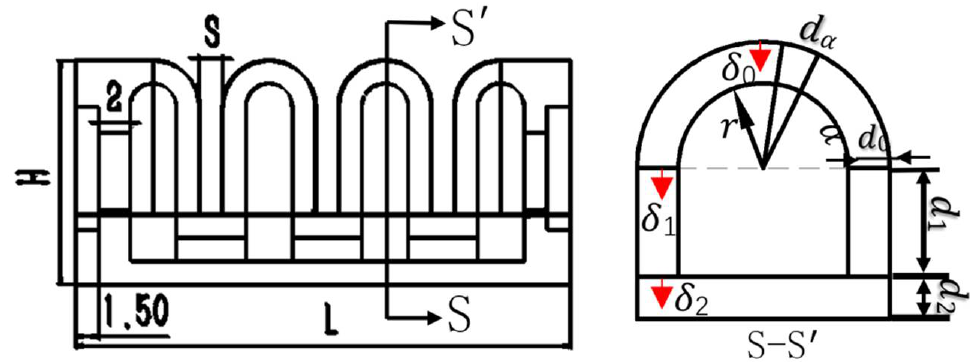
Figure 9. Soft finger structure. Table 4. Soft finger structure parameters